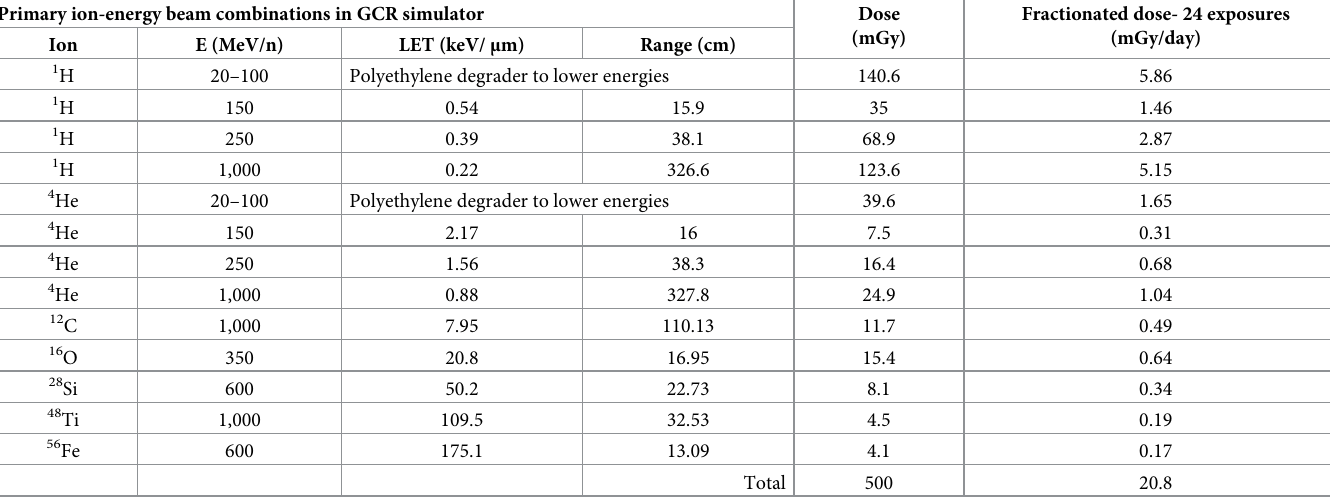
Table 3. “NSRL GCR Simulation” beam definition normalized to 500